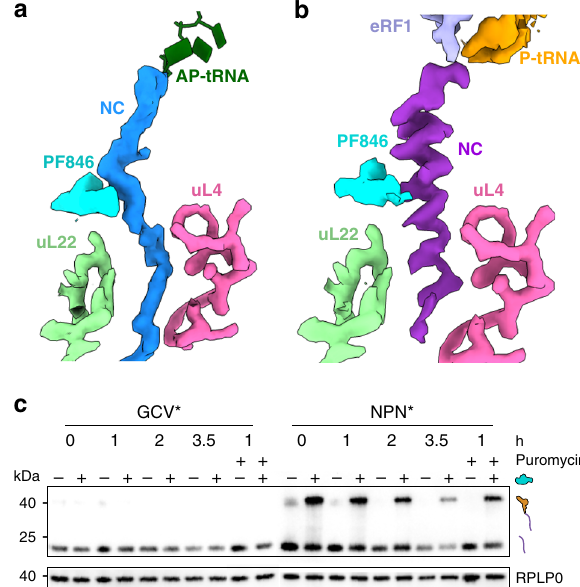
Fig. 2 Overview of PF846-stalled nascent chains in the ribosome exit tunnel. a The PF846-stalled nascent chain from the rotated RNC (light blue). Surface representations of the segmented cryo-EM density for PF846 and ribosomal proteins are indicated. b Cryo-EM density for the stalled nascent chain within the nonrotated RNC (purple). Surface representations of the segmented cryo-EM density for eRF1, P-site tRNA, PF846, and ribosomal proteins are indicated. c Western blots of CDH1 – GCV* and CDH1 – NPN* RNCs in the presence ( + ) or absence ( − ) of 50 μ M PF846 on different time scales at room temperature. Puromycin treatment was performed on pelleted RNCs at room temperature for 1 h with a fi nal concentration of 1 mM puromycin. The experiment shown in e was repeated three times independently with similar